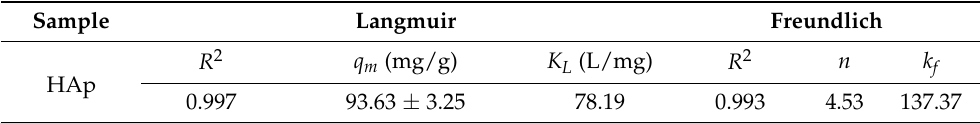
Table 1. Langmuir and Freundlich isotherm parameters for Sr 2+ adsorption onto HAp nanoparticles.